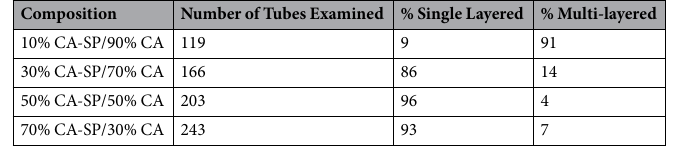
Table 1. Tube Layering observed for CA-SP/CA